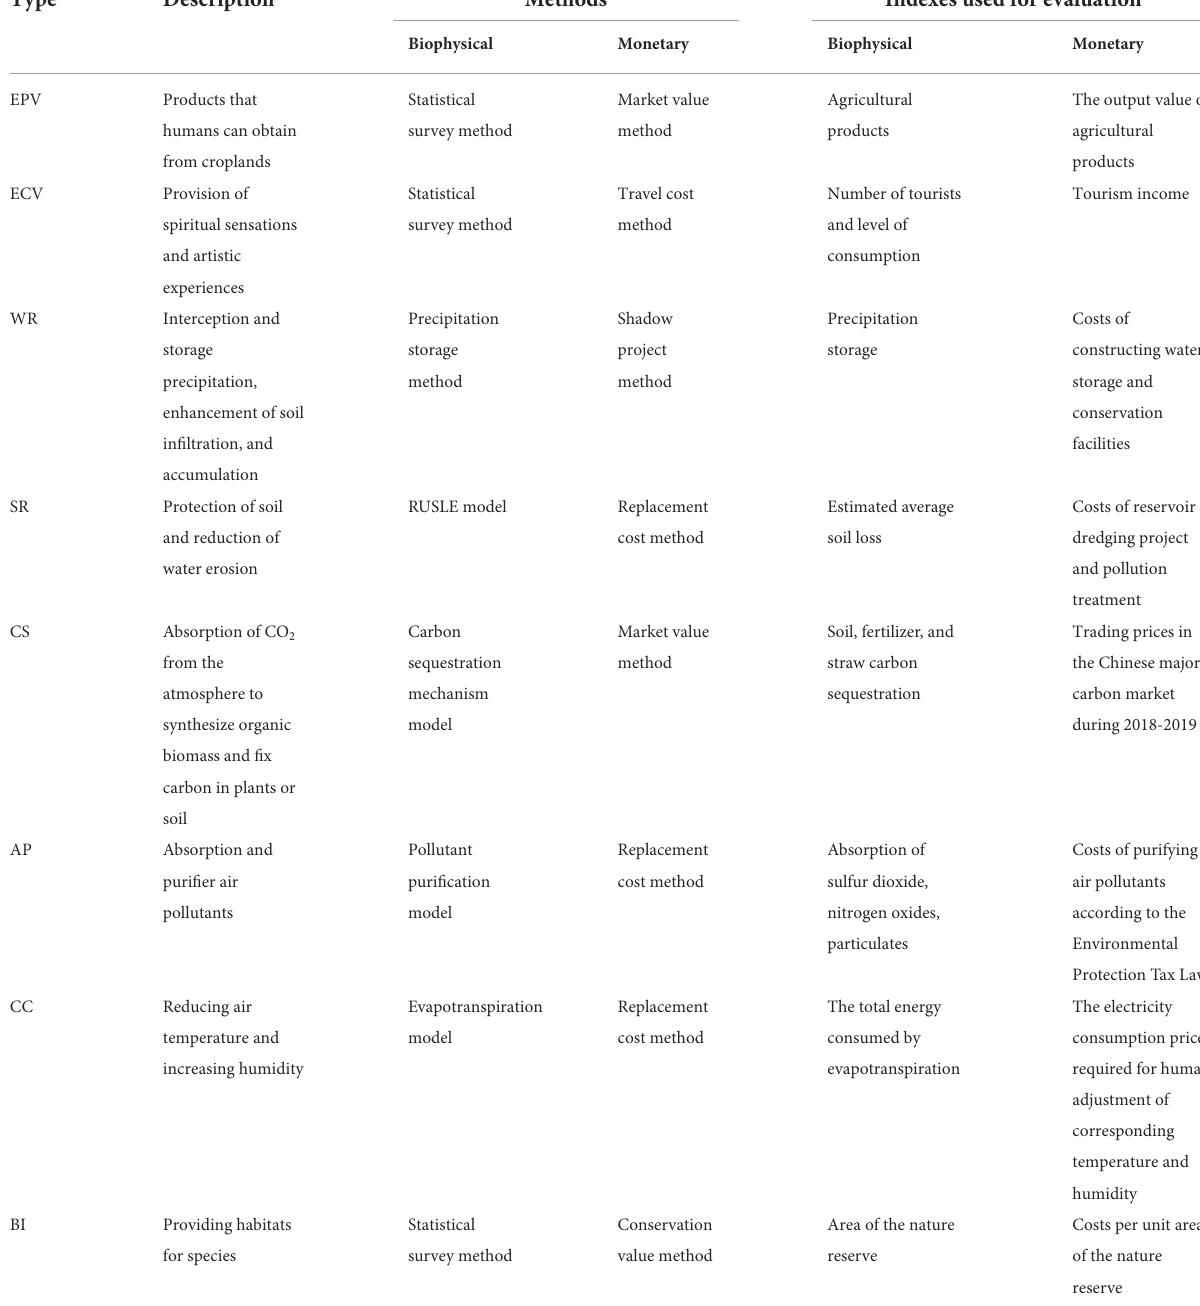
TABLE 1 Description of the evaluation methods of different types of ecosystem